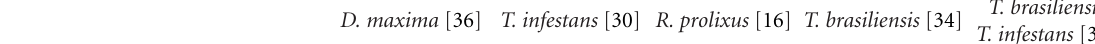
Table 1: Compounds identified from metasternal glands of di ff erent triatomine species (references cited in brackets).